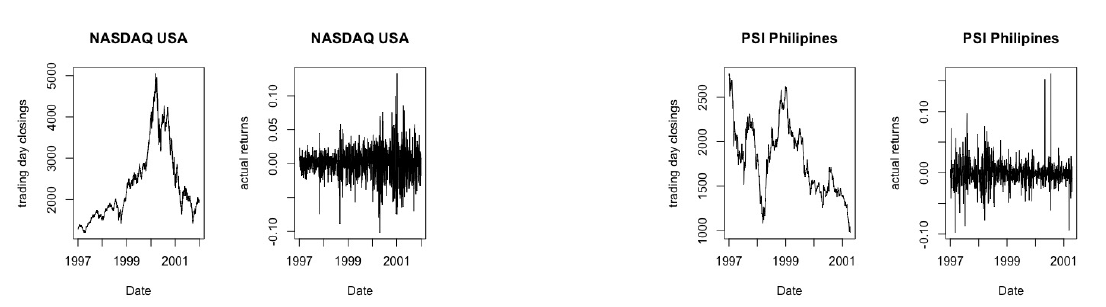
Figure 5. Plots of trading days closings and actual returns of Nasdaq and